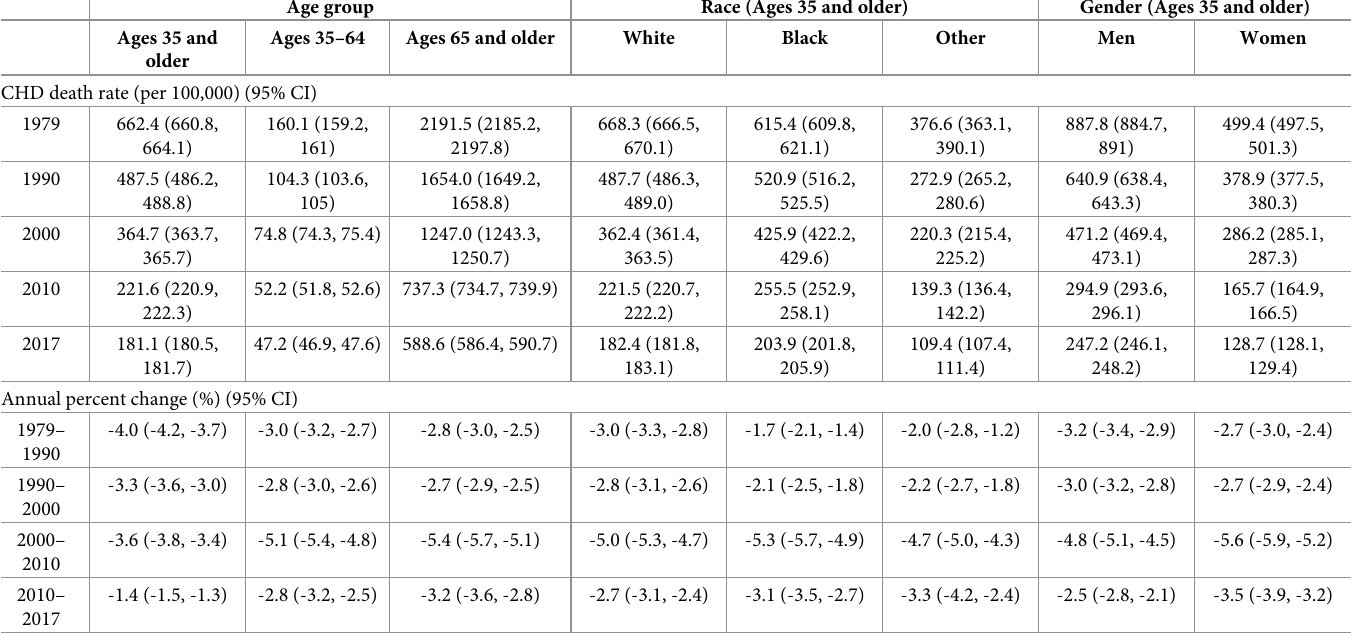
Table 1. National age-standardized CHD death rates and annual percent change in CHD death rates by year, race, gender, and age group, United States, 1979–